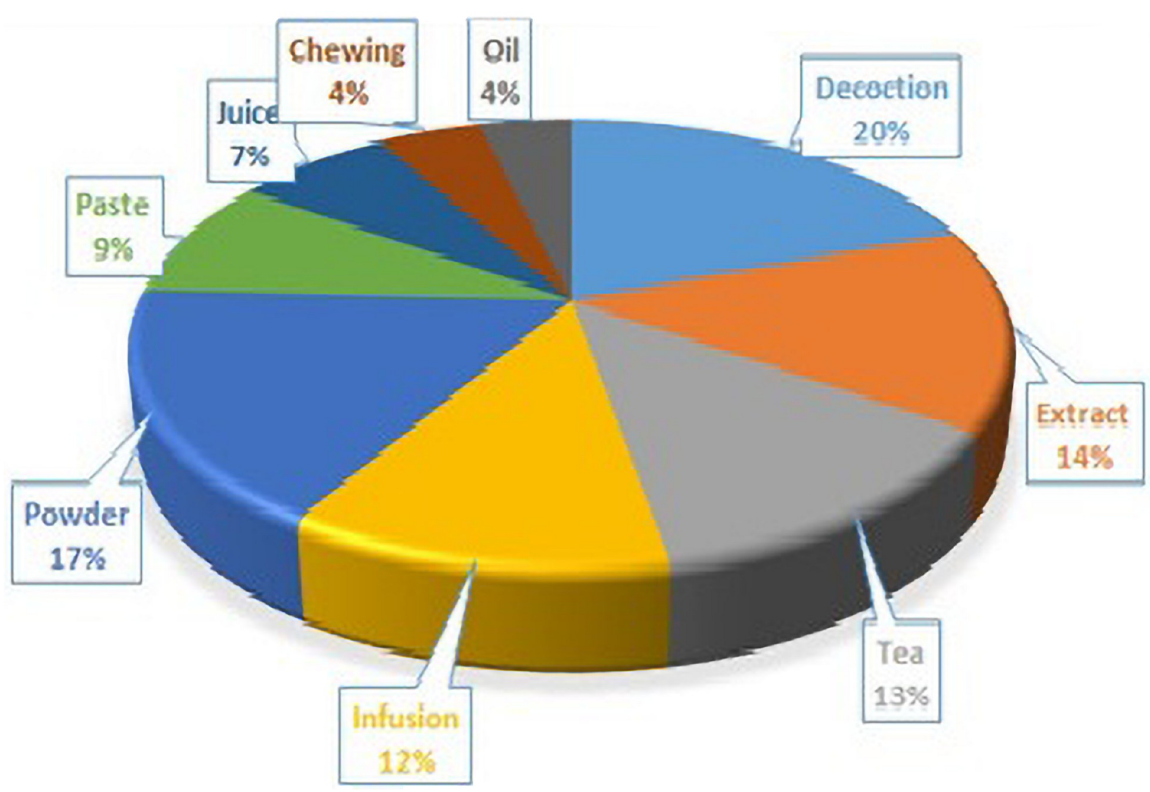
Fig 7. Depicting recipe forms used for the treatment of different diseases in study area of Dawarian and Rati Gali of District Neelam of Azad Jammu and Kashmir.